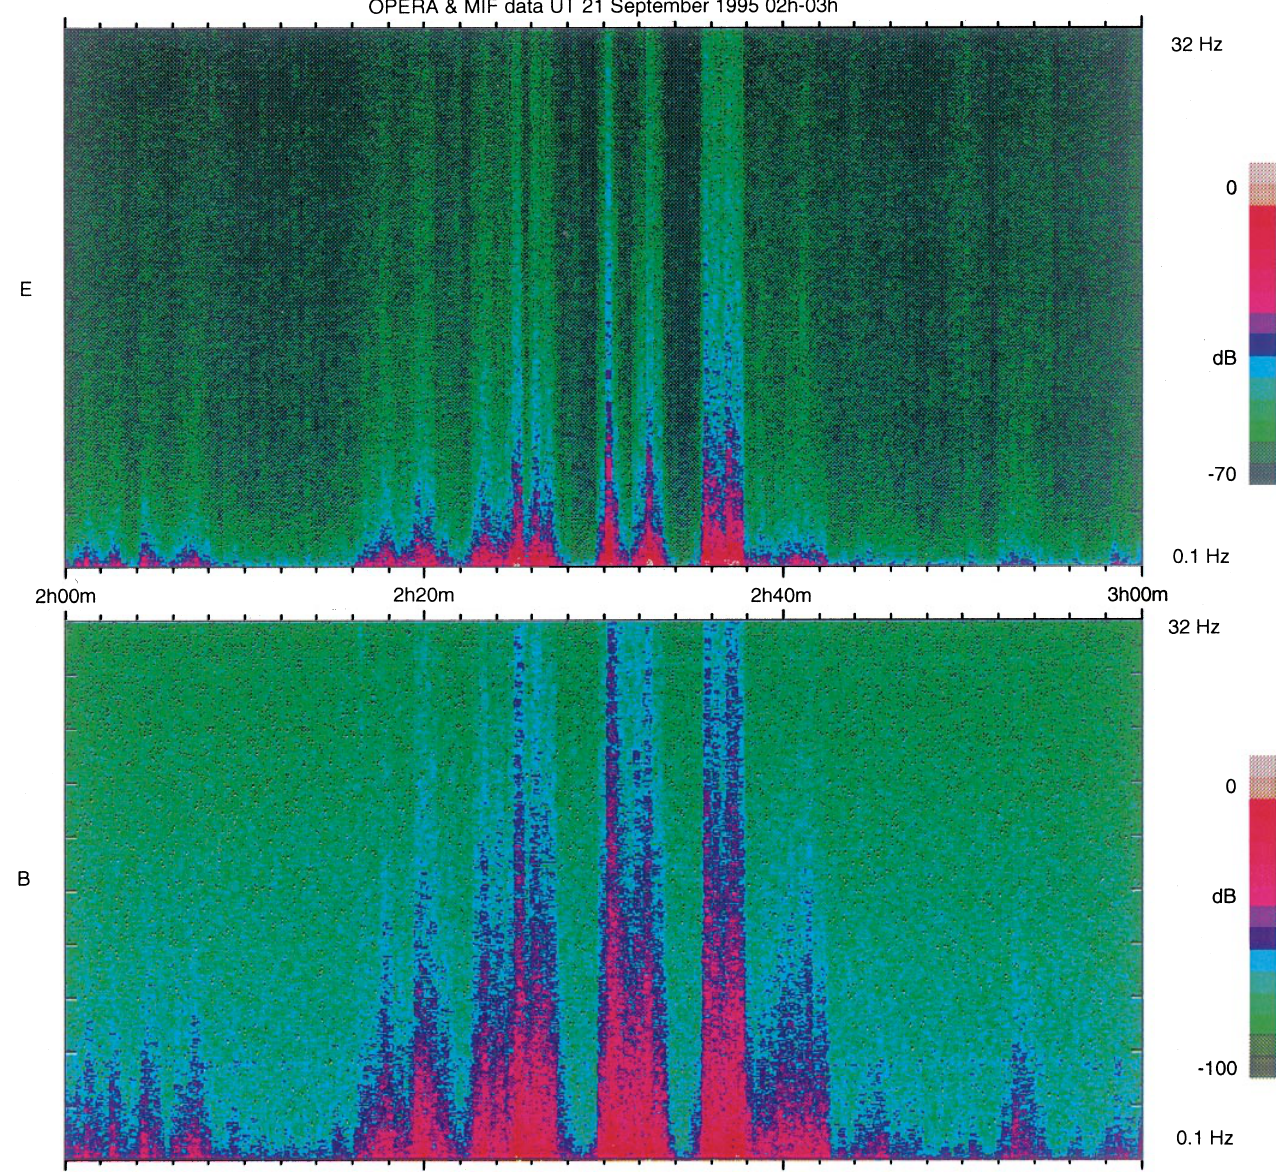
Fig. 10. Low-latitude magnetopause crossing 21 September 1995. Spectrograms of the E x ( top ) and B z ( bottom ) waveform signals. Frequency range is